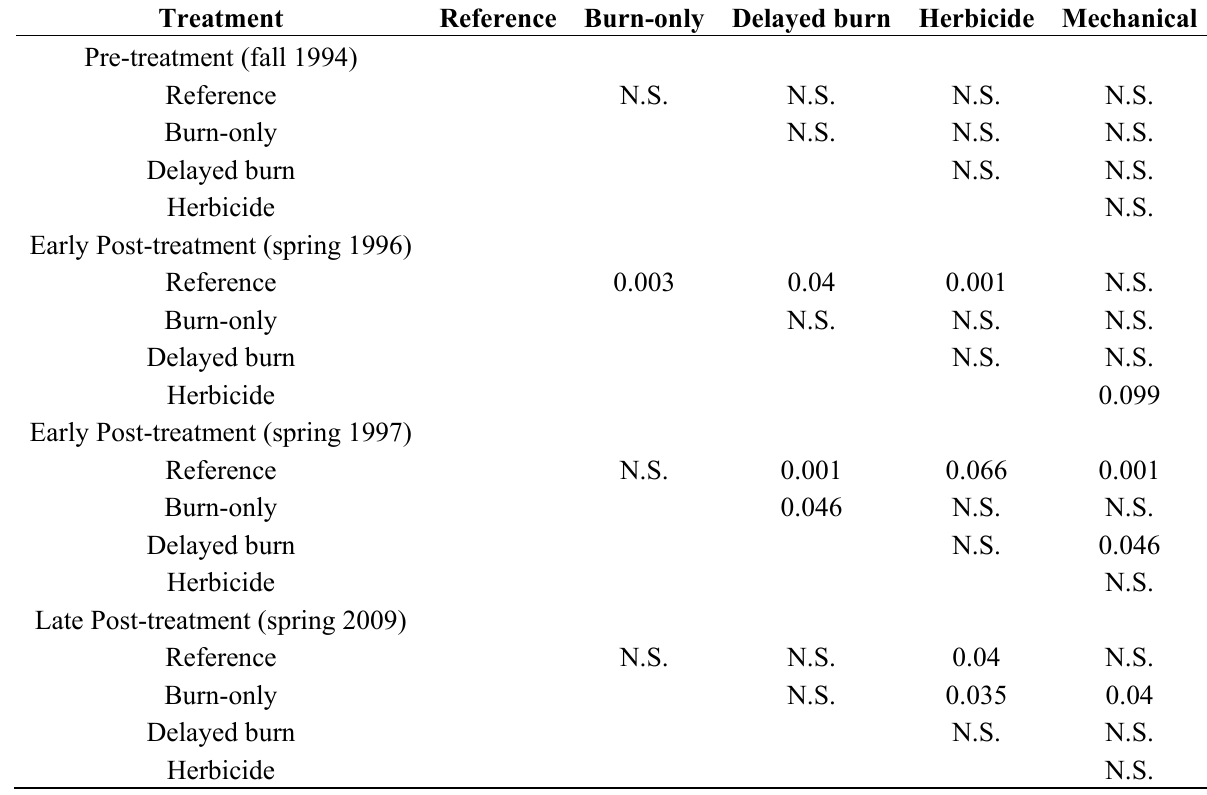
Table 2. Results ( p -values) associated with the multi-response permutation procedure (MRPP) on pairwise comparisons of soil total C, total N, and CN ratios on restoration treatments and reference sites for pre-treatment (fall of 1994) and post-treatment (spring of 1996, 1997, 2009) samplings. N.S. = not